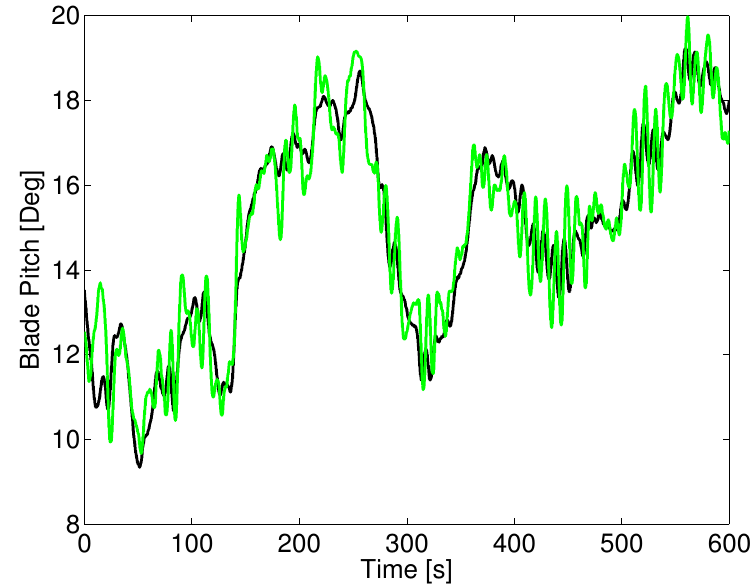
Figure 10. Aligned wind-wave forces with a peak wave period of 10 s: blade pitch angle. The green is the LQR2 controller, while the black is the baseline.